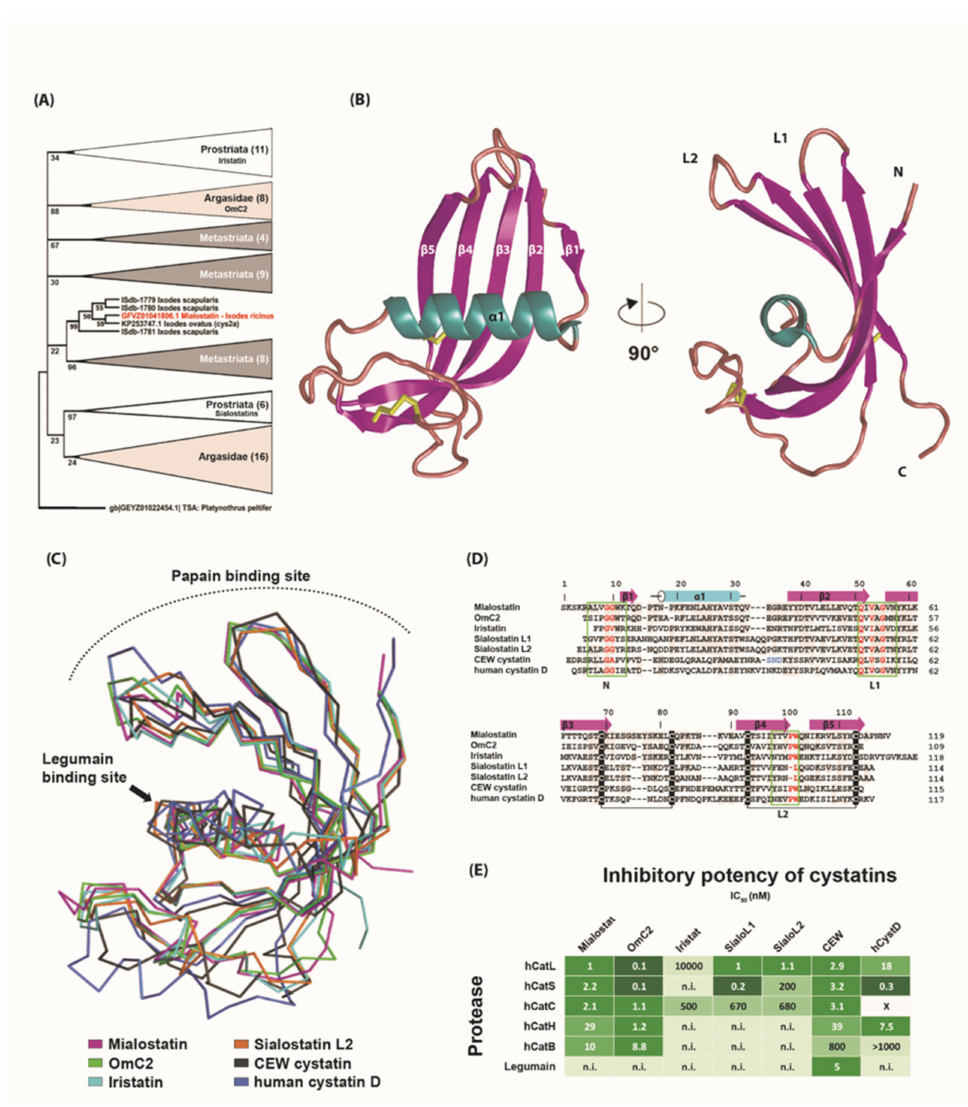
Figure 5. Crystal structure of mialostatin and its comparison with other family 2 cystatins. ( A ) Molecular phylogenetic analysis (maximum likelihood model) of secreted tick cystatins. Simpli- fied consensus tree based on the maximum likelihood method with 1000-repeat bootstrap support. All clades except the one with mialostatin (highlighted in red) are condensed. Cystatin from the mite Platynothrus peltifer was used as an outgroup. The tree with the highest log-likelihood ( − 4870, 9711) is shown. Branches corresponding to partitions reproduced in less than 20% bootstrap replicates are collapsed. Numbers next to branches represent percentage of trees, in which the associated taxa clustered together during bootstrap analysis. For full tree see Figure S1. ( B ) The three-dimensional structure of mialostatin (PDB code 6ZTK) is shown as a cartoon representation colored by secondary structural elements ( α 1—cyan; β 1-5—magenta). The N- and C-termini and two disulfide